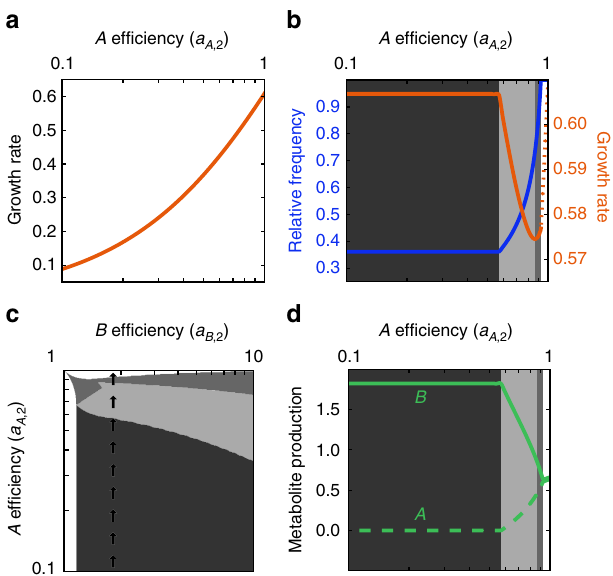
Fig. 4 The curse of decreased inef fi ciency. a The growth rate of type 2 cells in isolation increases as they improve in ef fi ciency of making A , the metabolite that they produce more poorly ( a B ,2 = 1.82, a A ,2 < 1). b Similar to the previous plot, but in the presence of a reference cell type ( a B ,1 = a A ,1 = 1). Here, as the type 2 cells increase in ef fi ciency of producing A , the population growth rate (orange) decreases in the light-gray region. This also corresponds to an increase in relative frequency of the type 2 cell (blue). c The shaded regions indicate where the population growth rate is constant (dark gray), decreasing (light gray), or increasing (middle gray) as type 2 cells improve in ef fi ciency in producing metabolite A , i.e., moving up along the indicated line. d The amount of B and A metabolites produced by type 2 cells is shown as a function of the ef fi ciency in producing A . In the light-gray region, where the population growth rate decreases, the type 2